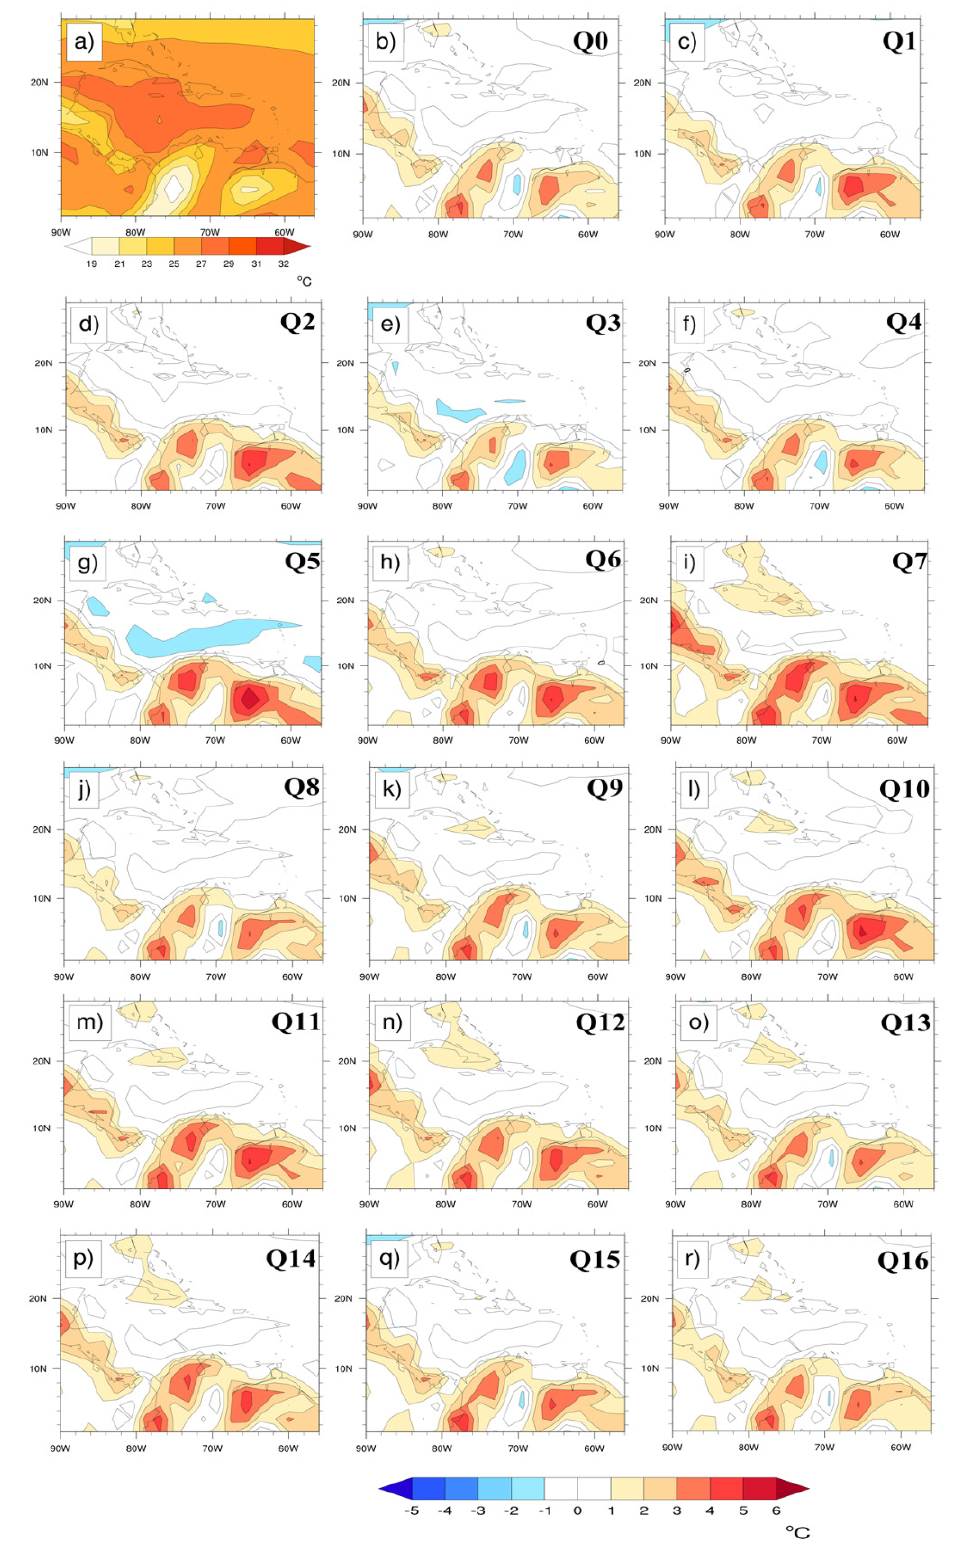
Figure 2. ( a ) Mean annual surface temperature from reanalysis. ( b – r ) The difference in mean annual surface temperature for each PPE (Q0 to Q16) from the pattern depicted in plot ( a ). All plots are averaged over the period 1960–1990. Units are in °C.